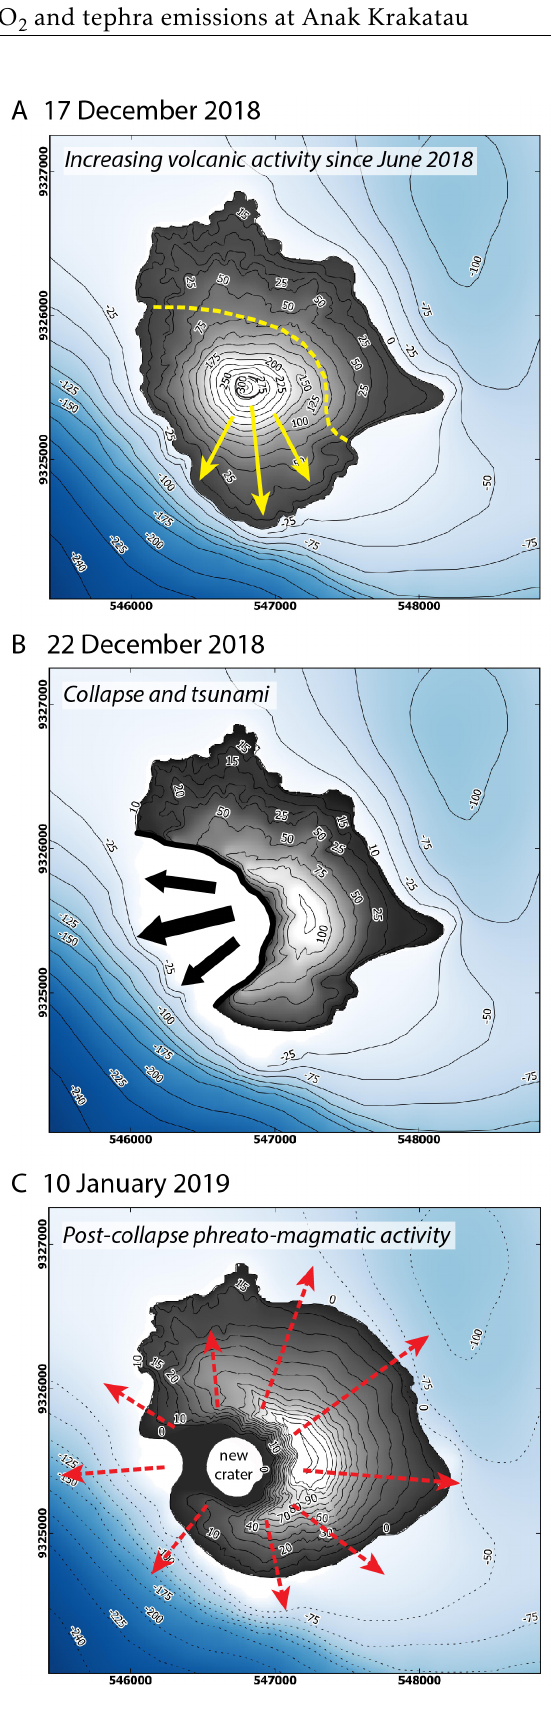
Figure 3: [Left] Evolution of the topography of Anak Krakatau volcano following the 22 December flank col- lapse. [A] 17 December 2018: lava flows emplaced since June 2018 (yellow arrows) are located on the south-western flank (southwest of the yellow dotted line).